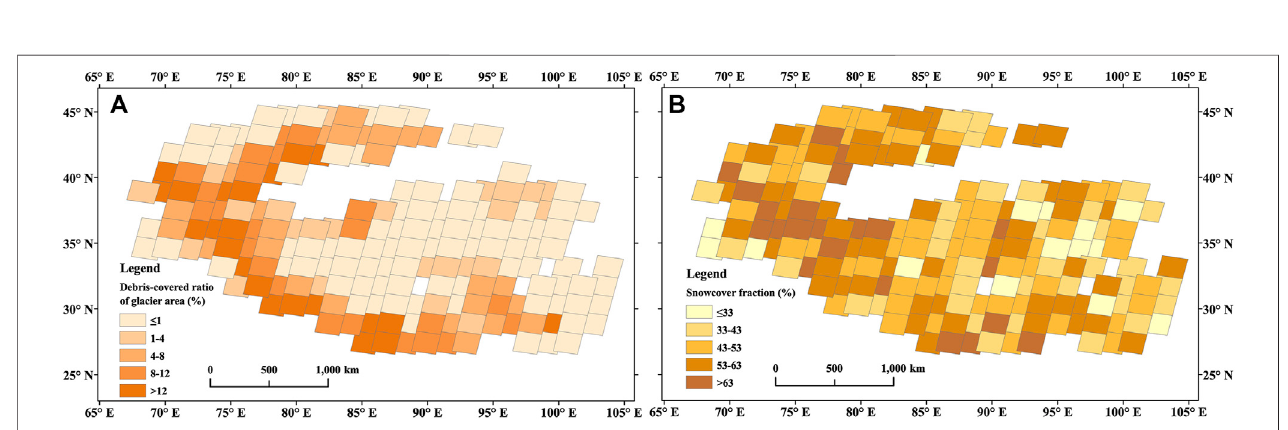
FIGURE 4 | The spatial distributions of (A) the debris-covered ratio of glacier area calculated using individual glacier datasets by Herreid and Pellicciotti (2020), (B) snowcoverfractioninthebufferzoneofaglaciercalculatedusingtheGGI18andthedailycloud-freesnowproductsofMODISinthenorthernhemisphere(Huang,2018) from 2000 to